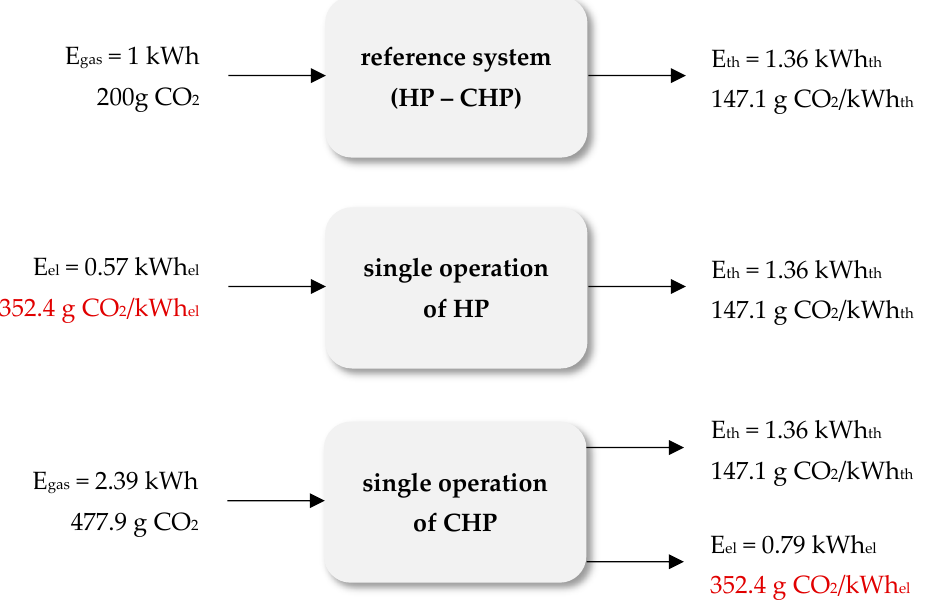
Figure 9. Methodology to determine the CO 2 threshold for the single operation of the HP and the CHP.